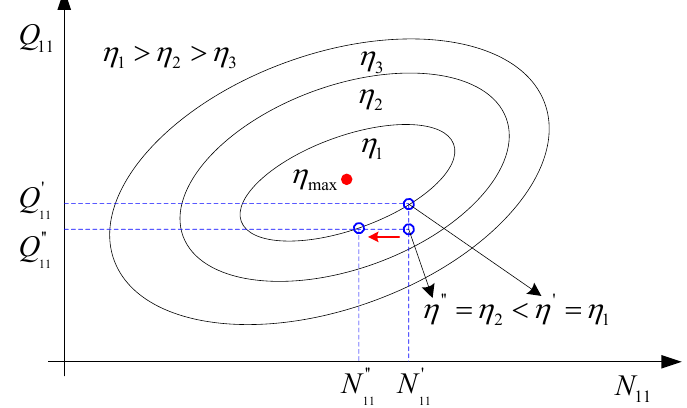
Figure 2. Diagram of ‘Hill Charts’ and the variable speed operation, η represents the turbine